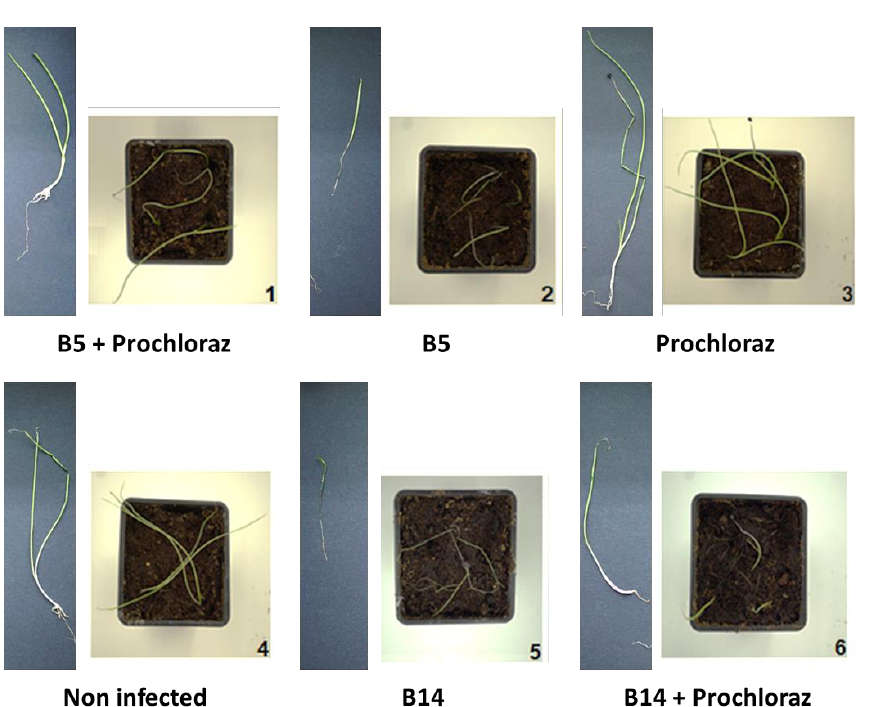
Figure 9. Photograph of representative pots ( right ) and sprouts ( left ) from the assay to evaluate the effectiveness of Prochloraz on emerging seedlings. The experimental procedure and the plants’ growth parameters results are described in Figure 8.